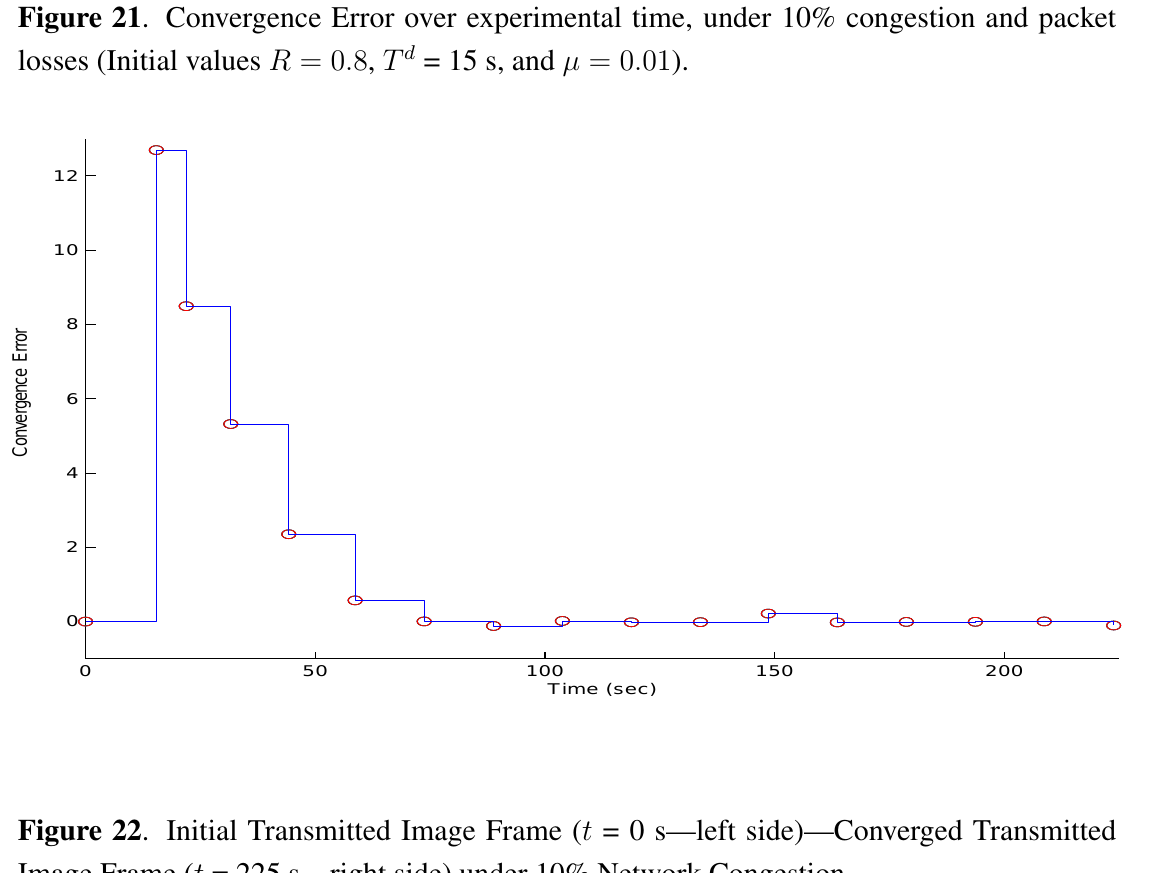
Figure 21 . Convergence Error over experimental time, under 10% congestion and packet